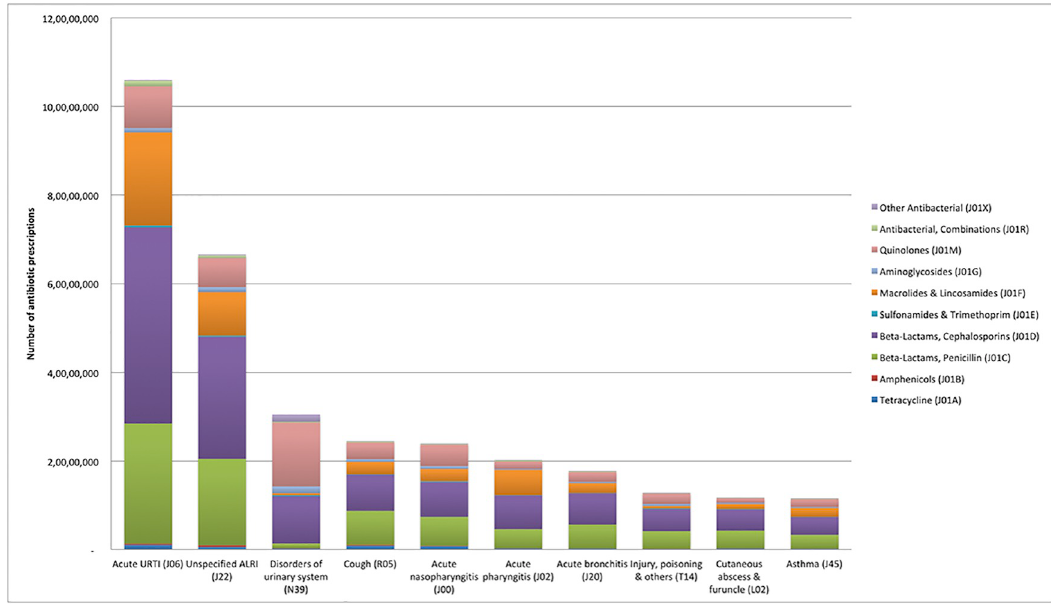
Fig 2. Number of antibiotic prescriptions, by disease conditions and antibiotic classes, India (2013–2014).